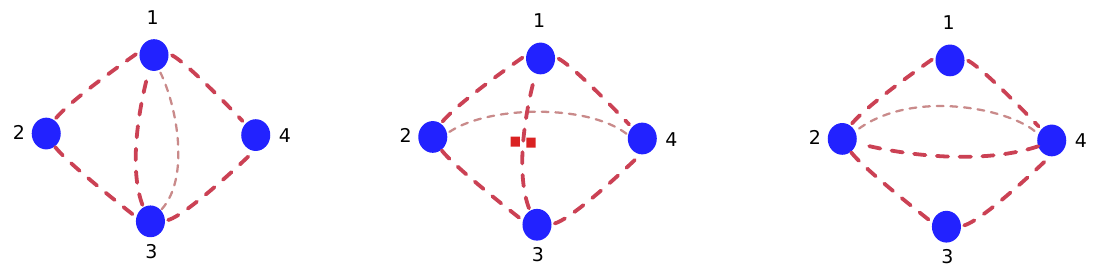
Figure 4 . Tilings for planar four-point functions: the left and the right panel show the two possible triangulations of the sphere (up to point permutations of the operators). In the middle we zoom in on gluing the two front hexagons by a single virtual